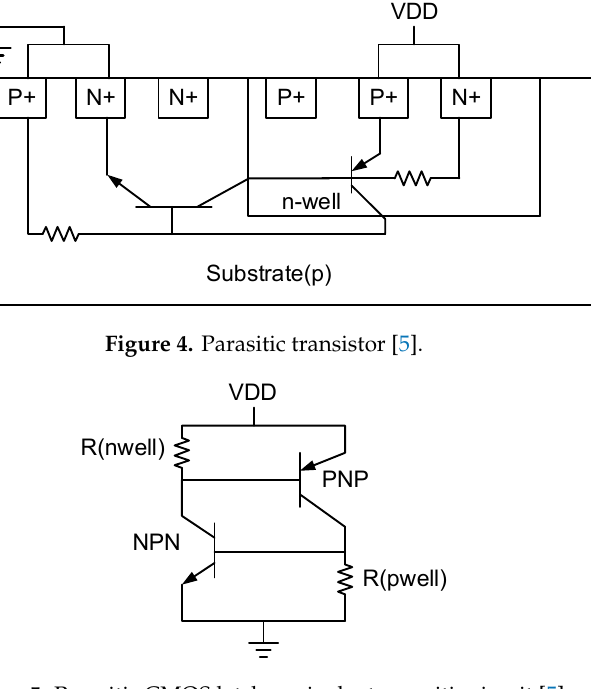
Figure 5. Parasitic CMOS latch equivalent parasitic circuit [5].